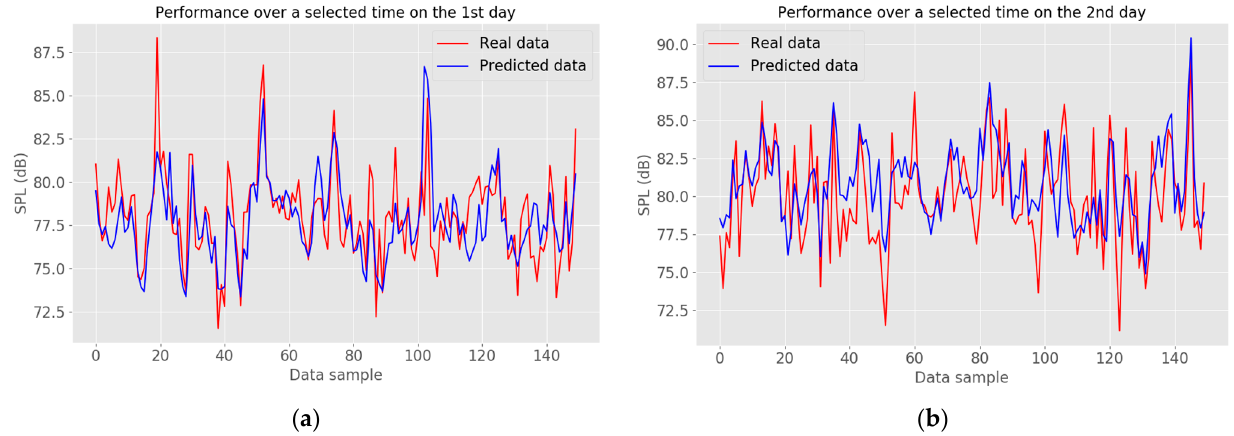
Figure 19. Illustrations of captured and estimated SPL data over a selected time on each day (data from Mic 8): ( a ) model prediction over a selected time on the first day; ( b ) model prediction over a selected time on the second day.